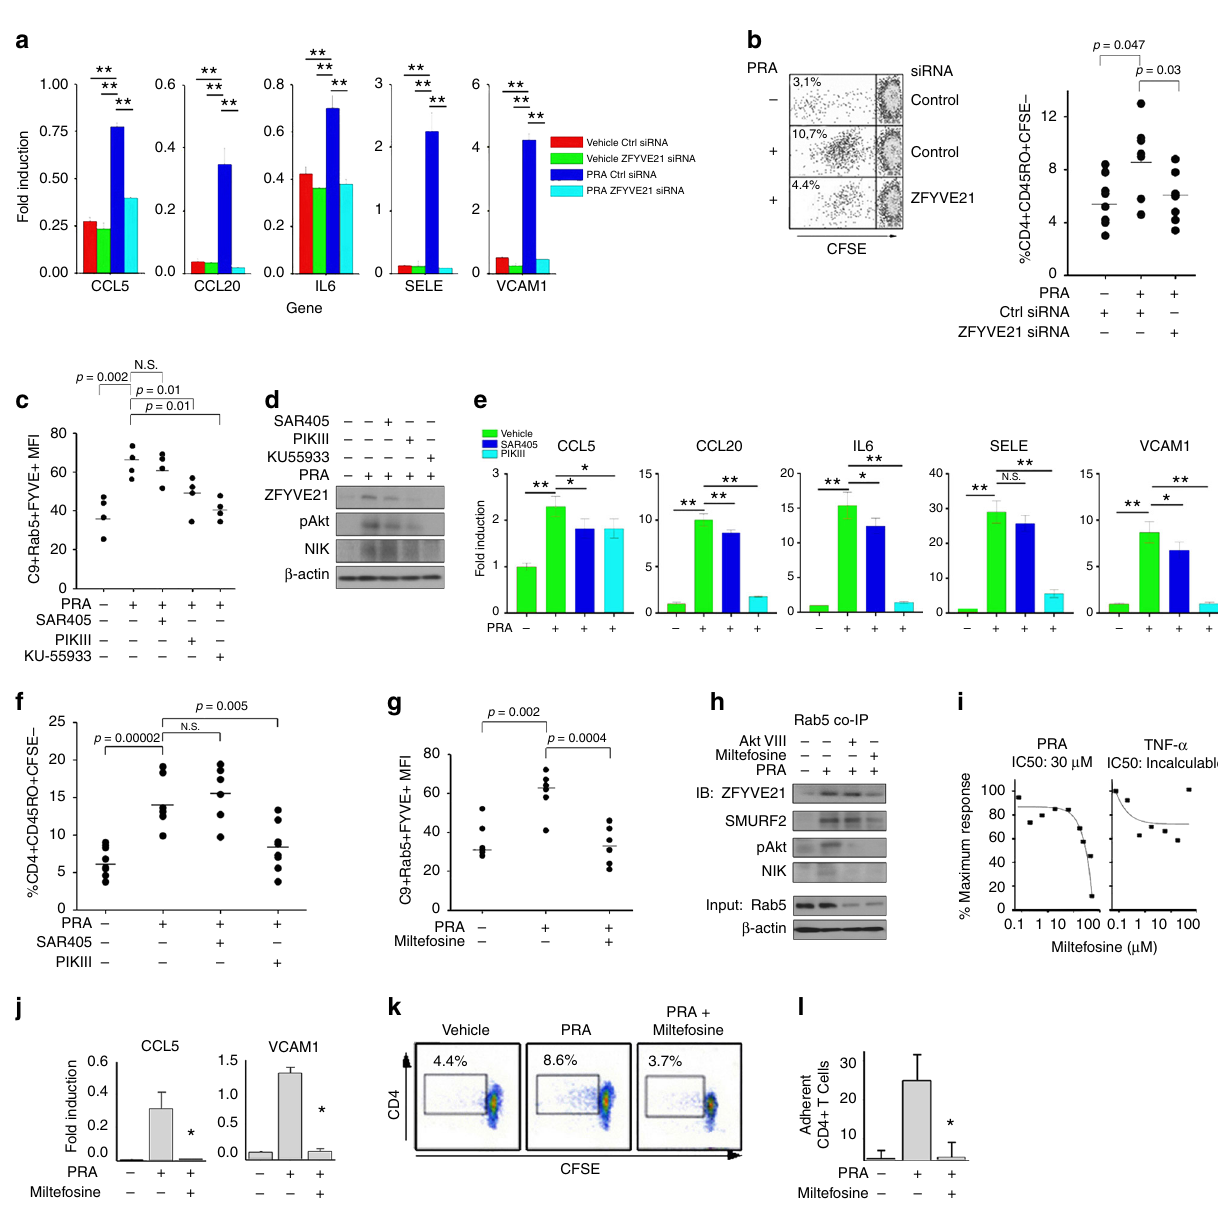
Fig. 4 Pharmacologic depletion of PI(3)P blocks ZFYVE21 expression. Human umbilical vein endothelial cells (HUVECs) transfected with control